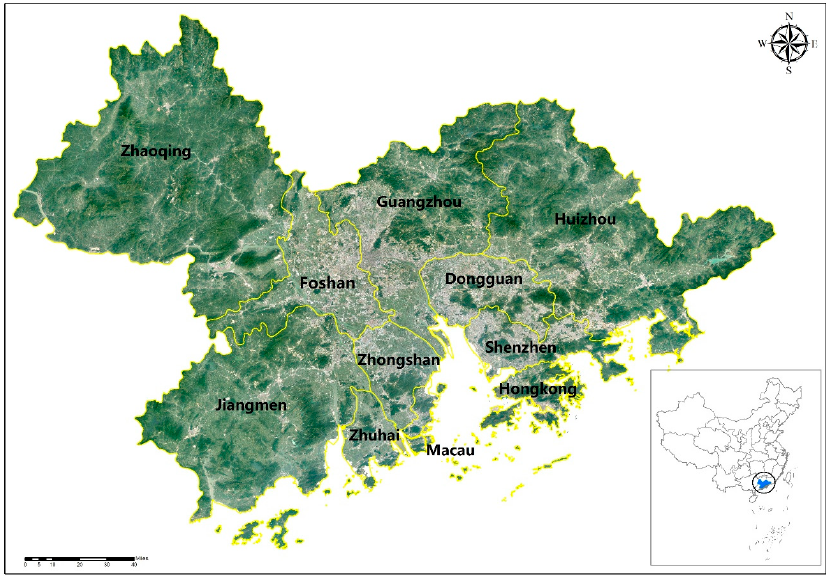
Figure 1. The location of the Guangdong-Hong Kong-Macau Greater Bay Area (GBA)